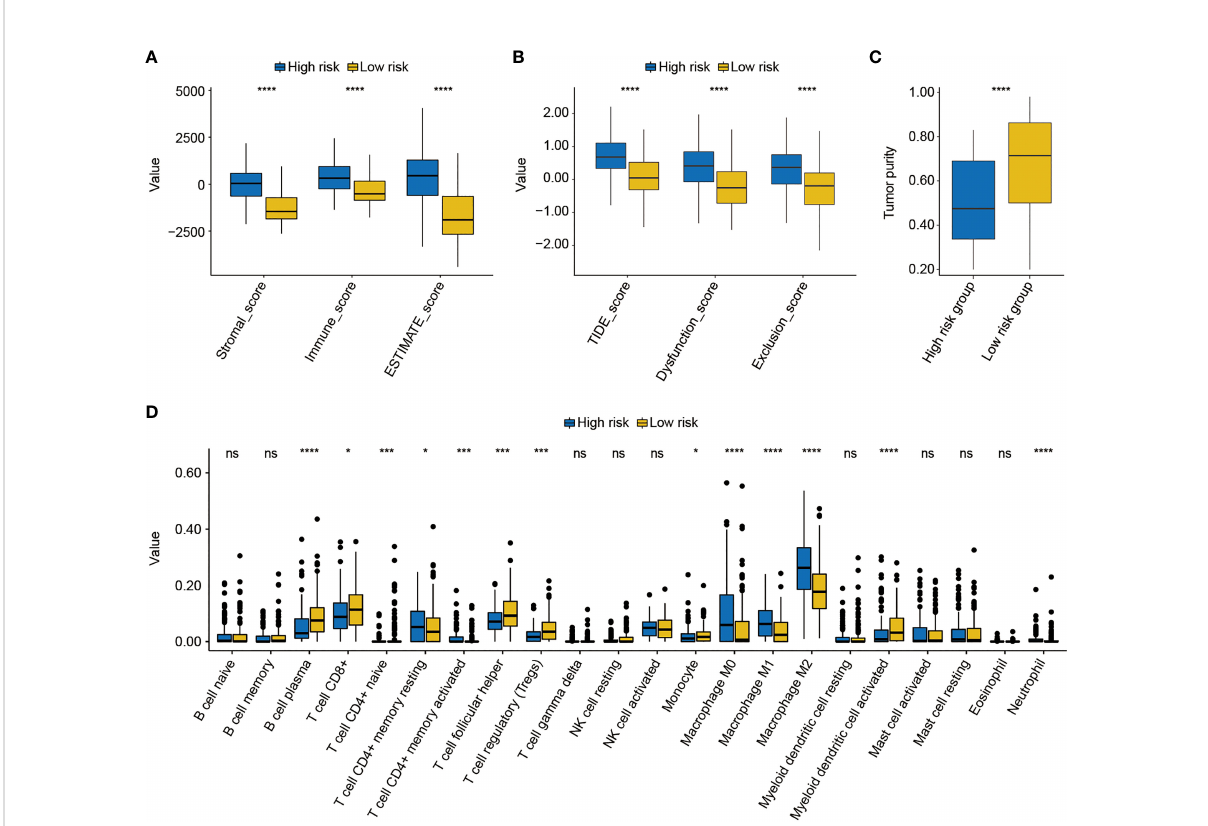
FIGURE 9 The analysis of the tumor environment between high- and low-risk groups. (A) Based on the ESTIMATE algorithm, it was found that low-risk BC patients had lower stromal, immune, and ESTIMATE scores. (B) Further analysis showed that low-risk BC patients had lower dysfunction, exclusion, and T-cell dysfunction and exclusion (TIDE) scores. (C) The evaluation of tumor purity of high- and low-risk BC patients. (D) The estimate of 22 common tumor-in fi ltrated lymphocytes between high- and low-risk groups. * indicated p < 0.05, *** indicated p < 0.001, **** indicated p < 0.0001, ns indicated no statistically signi fi cant